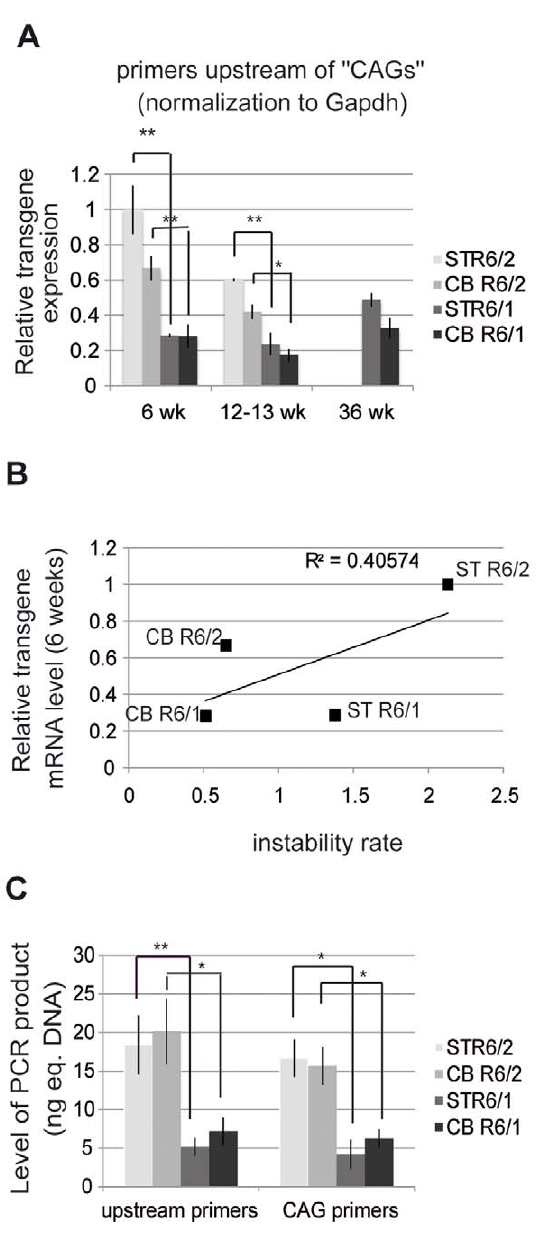
Figure 5. HD transgene expression in R6/1 and R6/2 striatum and cerebellum. A. Expression of the HD transgene in the striatum and in the cerebellum of R6/1 and R6/2 mice of various ages, as assessed by qRT-PCR using primers located upstream of CAG repeats in HD exon-1. Expression values were normalized to Gapdh expression. Error bars, sem; *, p , 0.05; **, p , 0.01. B. Correlative analysis of CAG instability rates and HD transgene mRNA levels at 6 weeks of age. C. Absolute quantification of HD transgene transcript levels, as assessed by qRT-PCR using primers upstream of the repeats (upstream primers) and primers amplifying the repeats (CAG primers), from the striatum and cerebellum of R6/1 and R6/ 2 mice of 6 weeks of age. Corresponding genomic DNAs were used as standards. Levels of PCR products are expressed as equivalent DNA (1 ng eq. DNA corresponds to the PCR signal obtained using 1 ng of DNA). Error bars, sem; *, p , 0.05; **, p ,